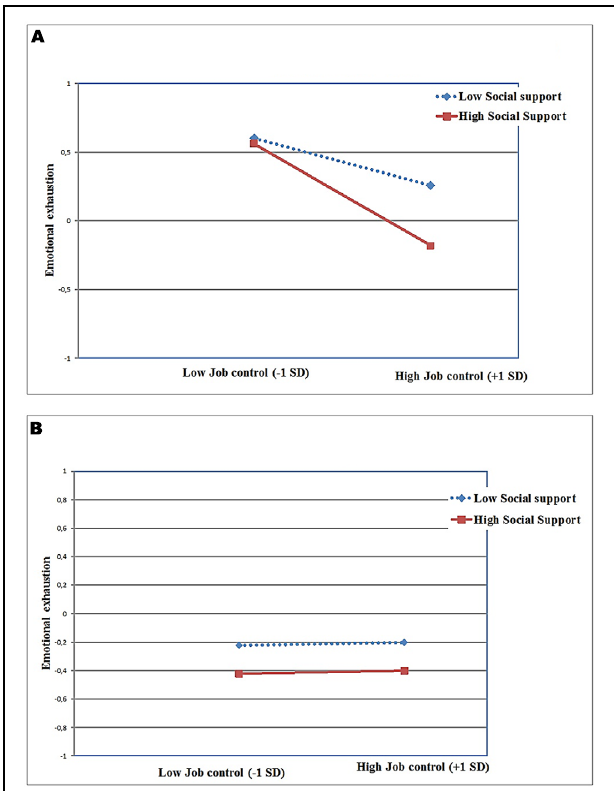
FIGURE 4 | (A) Job control X Social support X OCSE predicting emotional exhaustion in low OCSE. (B) Job control X Social support X OCSE predicting emotional exhaustion in high